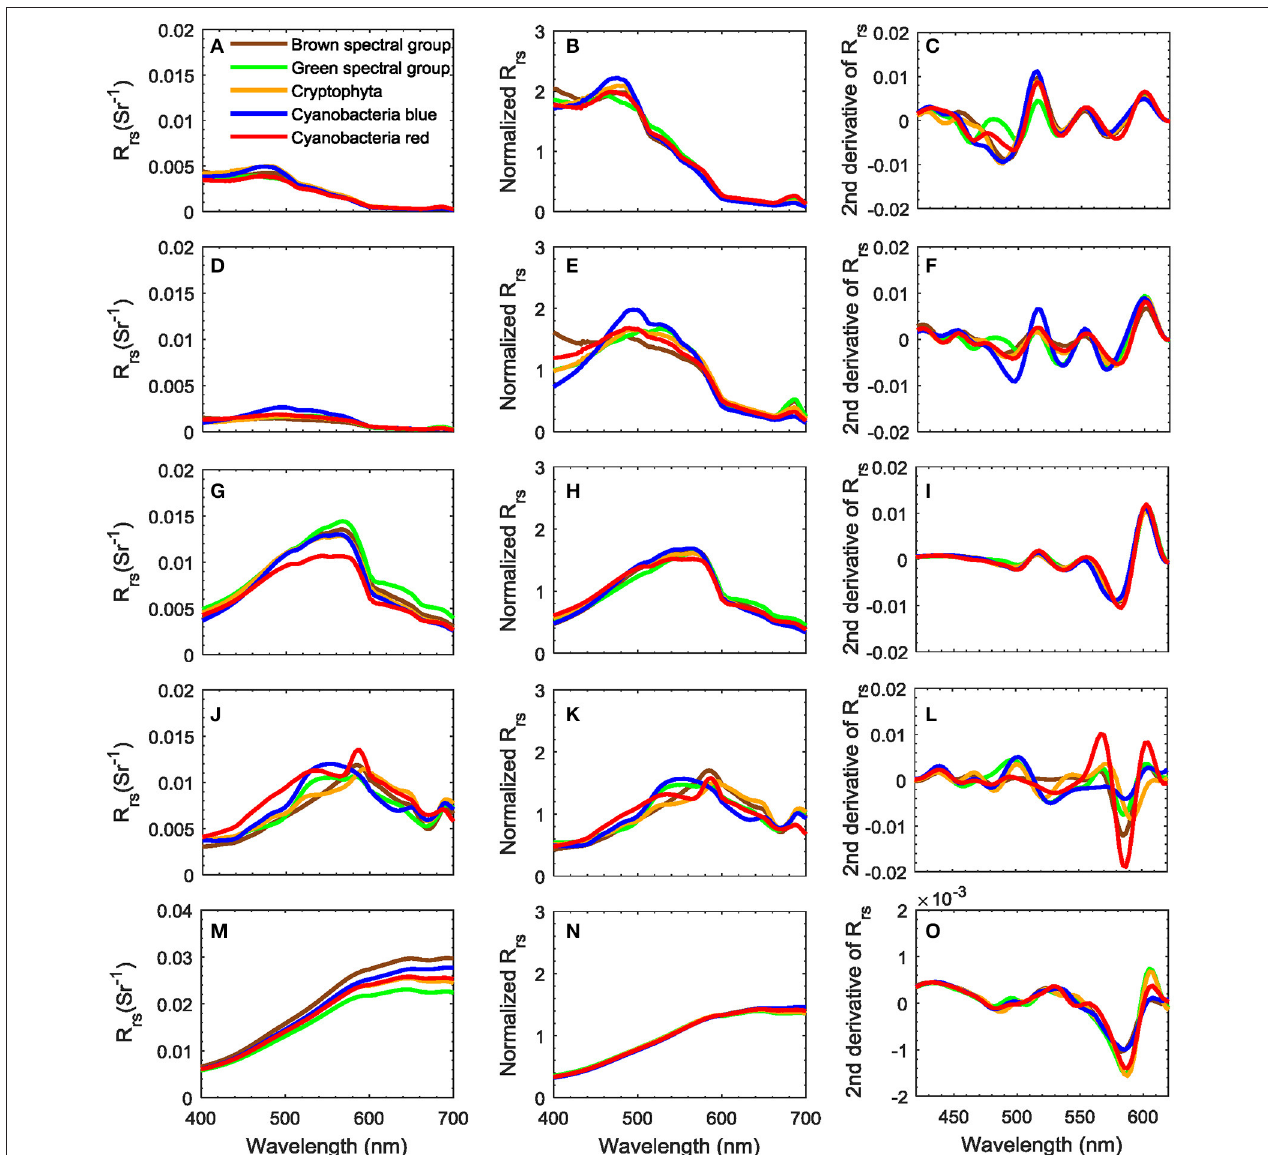
FIGURE 4 | Representatives of R rs ( λ ) spectra (first column), the corresponding area-normalized R rs ( λ ) spectra (second column) and second derivative spectra (third column) for five phytoplankton spectral groups and different water conditions. (A–C) Low [Chl], [NAP], and CDOM; (D–F) low [Chl] and [NAP], moderate CDOM; (G–I) low [Chl], moderate [NAP] and CDOM; (J–L) high [Chl], moderate [NAP] and CDOM; and (M–O) moderate [Chl], extremely high [NAP], and moderate CDOM. Note that the second derivative spectra were only for 420–620 nm, i.e., the spectral range used in the identification approach.